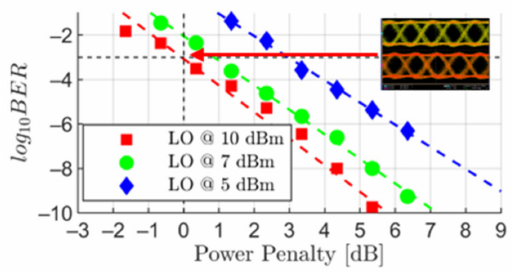
Figure 10. LO power dependency of the system and recovered eye